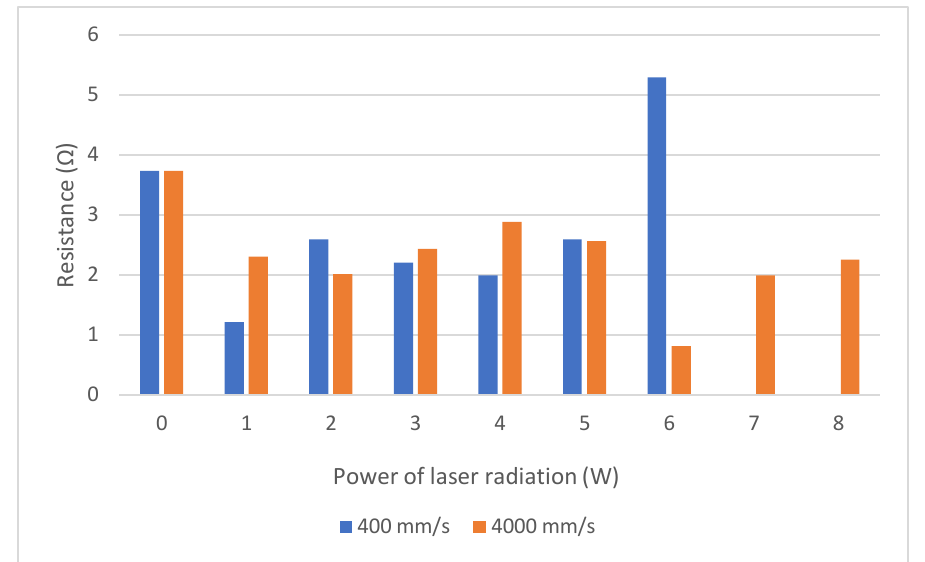
Figure 10. The surface resistance of the thin silver layer as a function of the power of laser radiation.